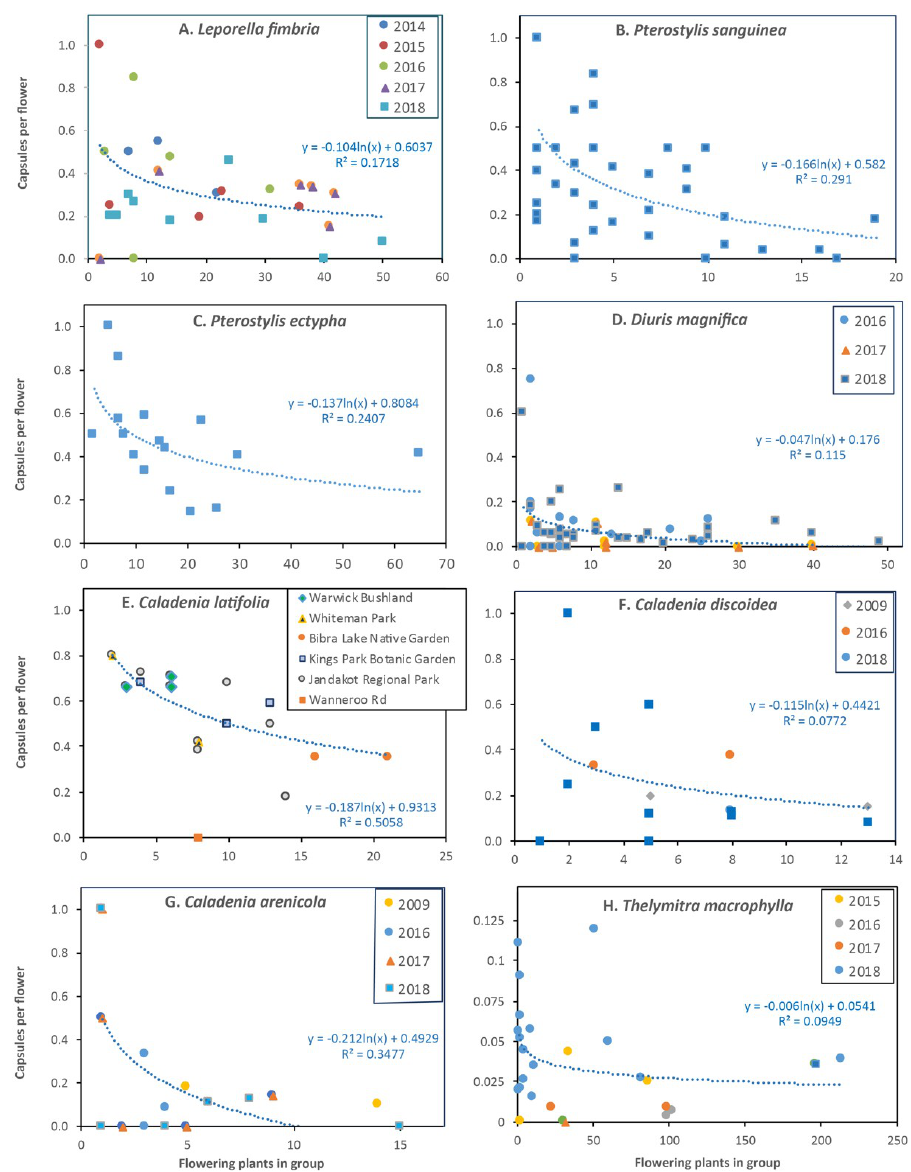
Figure 6. Relationships between plant density (plants within 5 m) and fruit set per flower for 8 orchid species with regressions to show the e ff ect of plant density. Data are for a single year and location unless separate symbols are used.